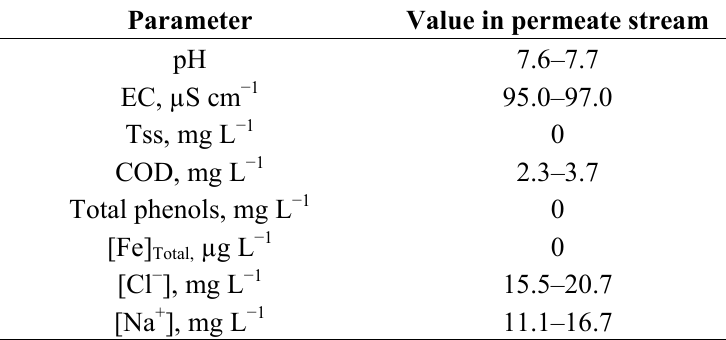
Table 8. Physicochemical composition of permeate stream.